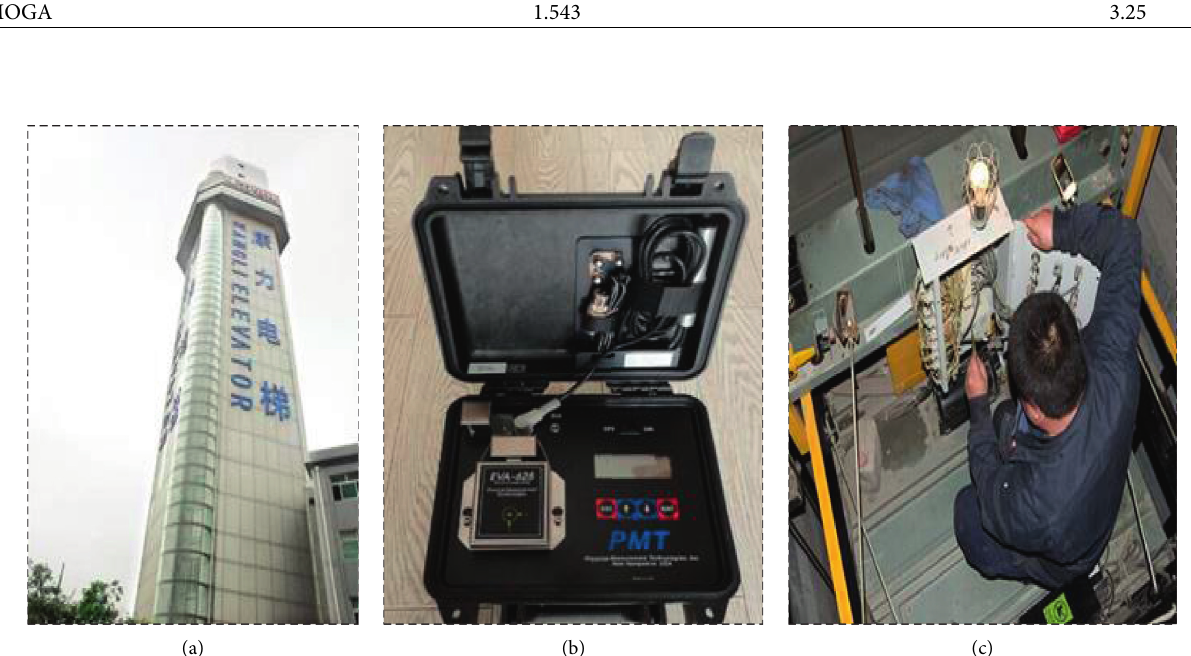
Figure 16: Horizontal vibration performance test of the KLK2 high-speed elevator prototype. (a) Elevator experimental tower. (b) PMT EVA-625. (c) Test